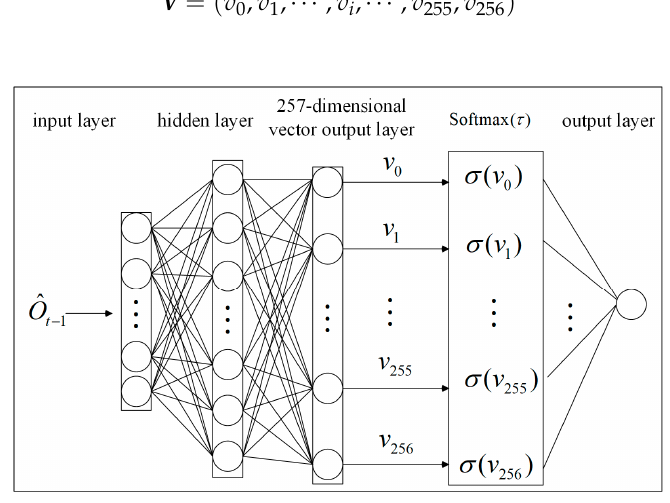
Figure 2. RNN expansion model based on time series: ( a ) the learning stage of the RNN model; ( b ) the generation stage of the RNN model.